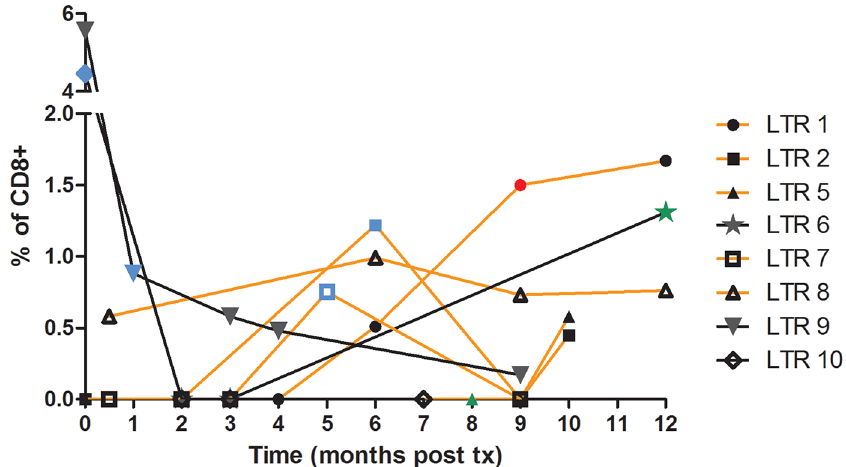
Fig 3. UL40-specific T cell dynamics correspond to clinical events in lung transplant recipients. Longitudinal samples were collected from 15 LTR for 12 months post-transplant and PBMC were stained with HLA-E tetramers refolded with the UL40 epitope in the presence of blocking CD94 mAb. Graph shows UL40-specific T cells as a percentage of total CD8+ T cells for 8 patients where a population of UL40-specific T cells was observed for at least one time point (LTR #10 only observable pre-transplant). Blue symbols: Acute rejection (AR) episode as determined by transbronchial biopsy; Green symbols: Cytomegalovirus (CMV) reactivation as determined by PCR in bronchoalveolar lavage; Red symbol: concurrent AR and CMV; Orange lines: LTR who developed chronic allograft dysfunction, manifested as Bronchiolitis Obliterans Syndrome (BOS).